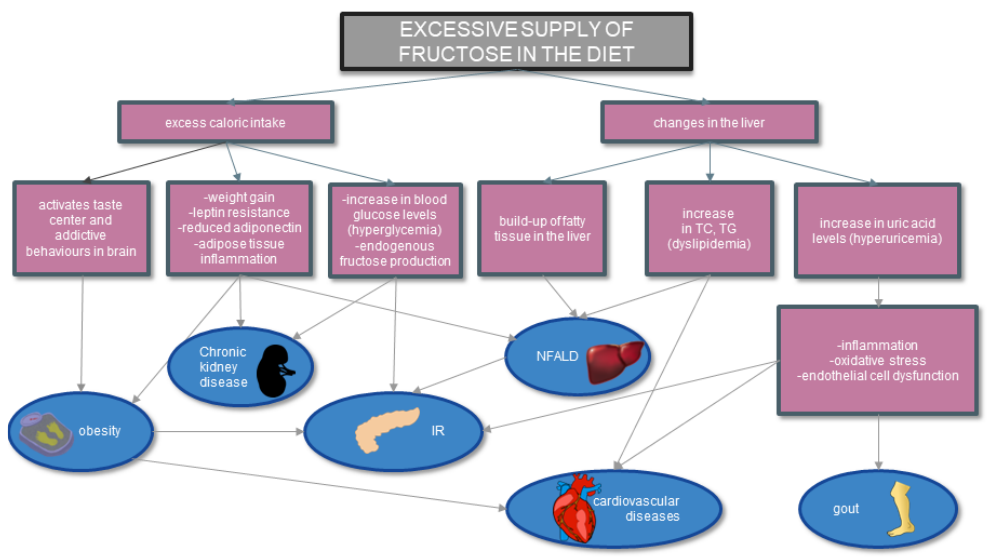
Figure 3. Effect of fructose on metabolic diseases based on [8,45,63]. Excessive consumption of fructose leads to both increased caloric intake and changes in the liver. As a result of such an incorrect diet, there are a number of changes in the body that lead to obesity, IR, NFALD,